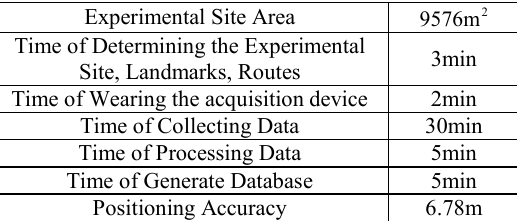
Table 6 . Test Site Area, Experiment Time,